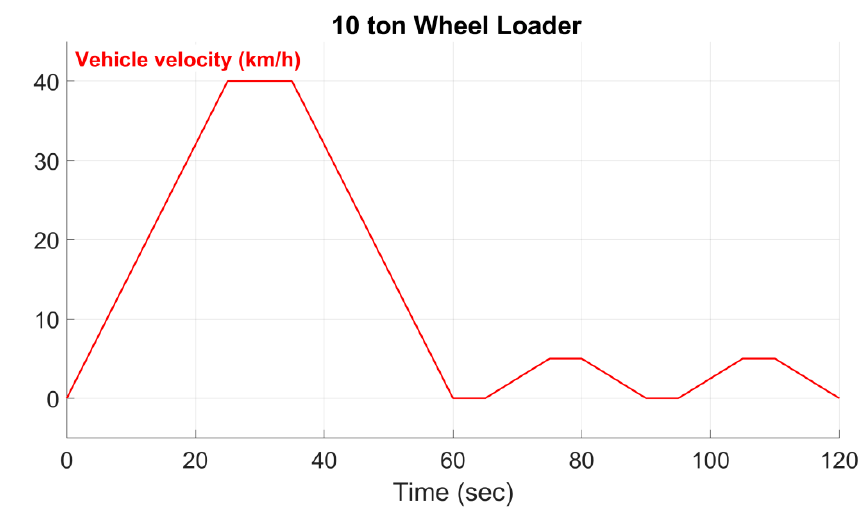
Figure 8. Commanded wheel loader motion profile.